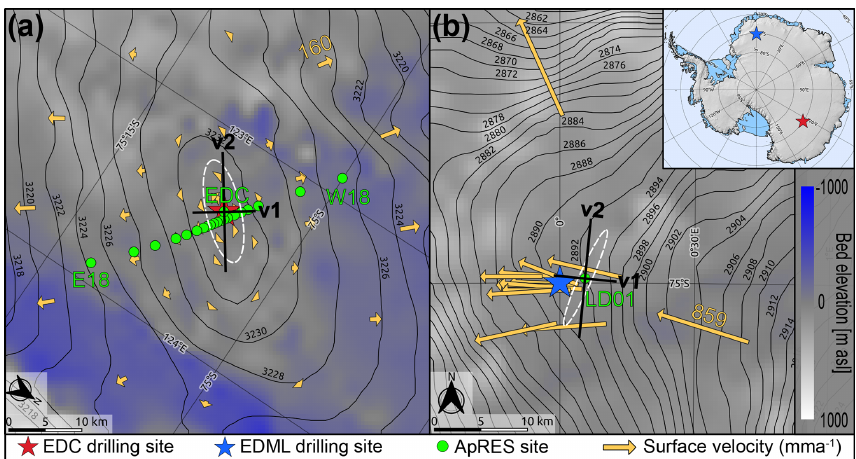
Figure 1. Map of the study areas. (a) EPICA Dome C (EDC). (b) EPICA Dronning Maud Land (EDML). Black contour lines are the surface elevation (Helm et al., 2014). The background color is the bed elevation (Morlighem et al., 2020). Yellow arrows are the magnitude and direction of the surface velocities at EDC (Vittuari et al., 2004) and EDML (Wesche et al., 2007). The white strain ellipses mark the directions of the maximum and minimum strain rate. The ice fabric’s horizontal eigenvectors are represented by v 1 and v 2 , and they are based on the results in Sect. 4.1 and 4.2. Note that (a) and (b) have a different scale and orientation.